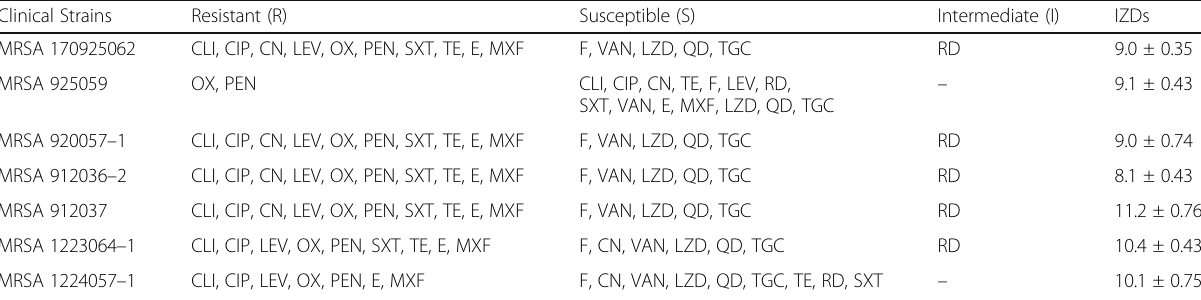
Table 2 IZDs (mm) of the PGF against different MRSA strains Clinical